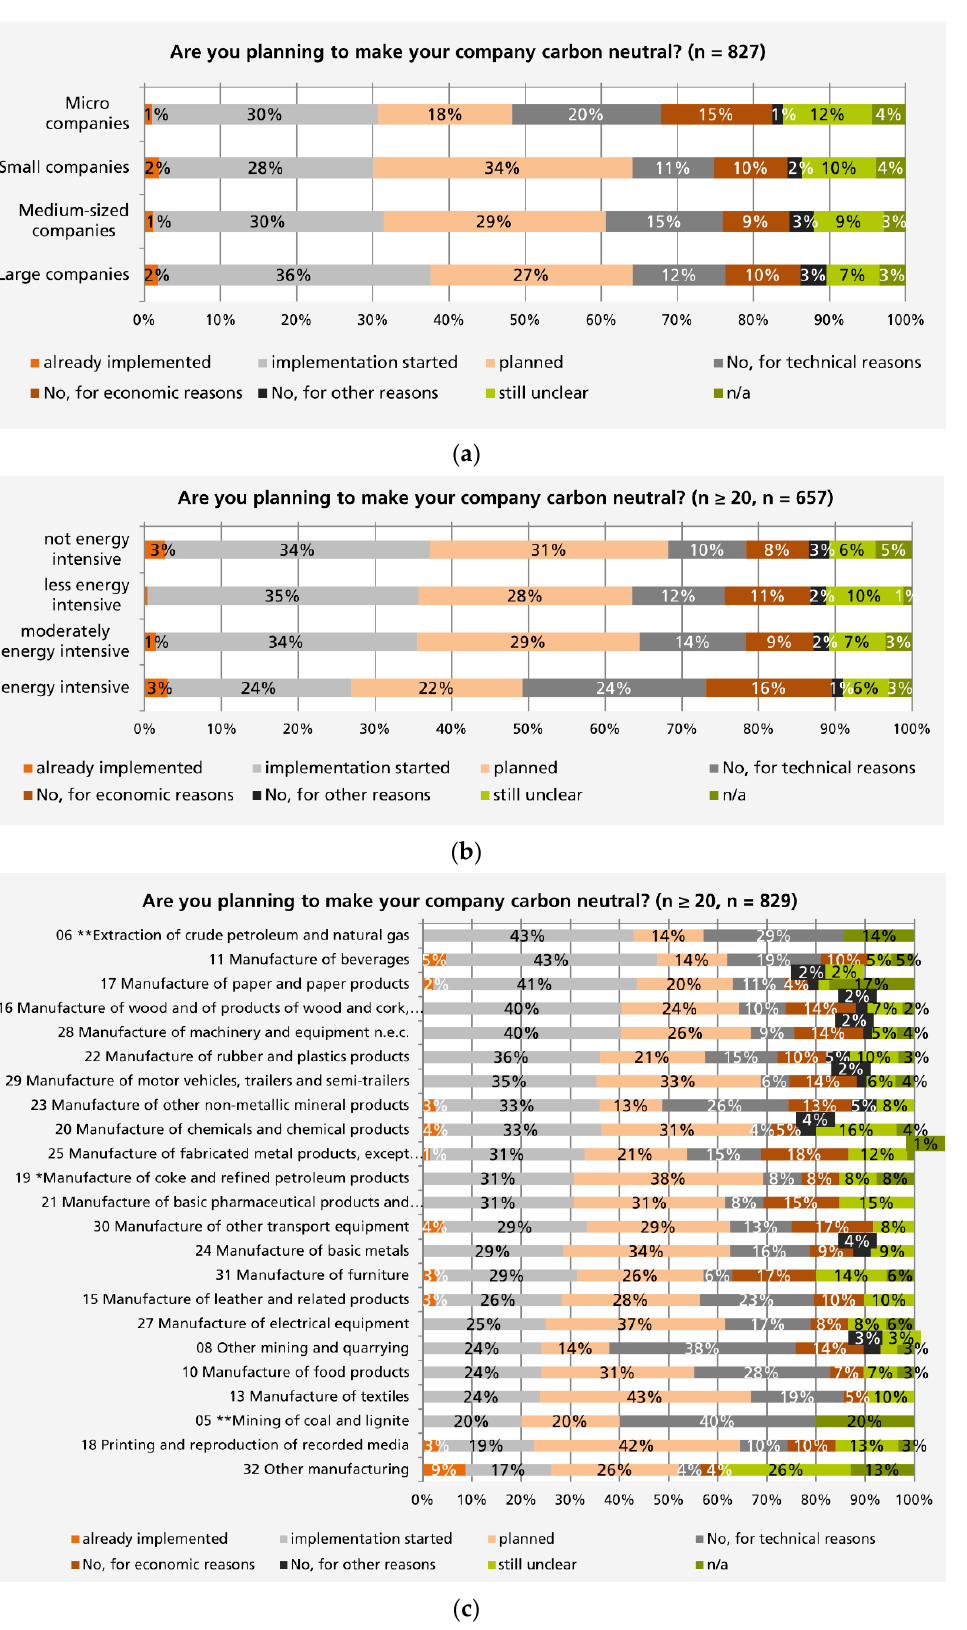
Figure 4. ( a ) Plans to become net zero carbon, by company size; ( b ) plans to become net zero carbon, by energy intensity; and ( c ) plans to become net-zero carbon, by sector.